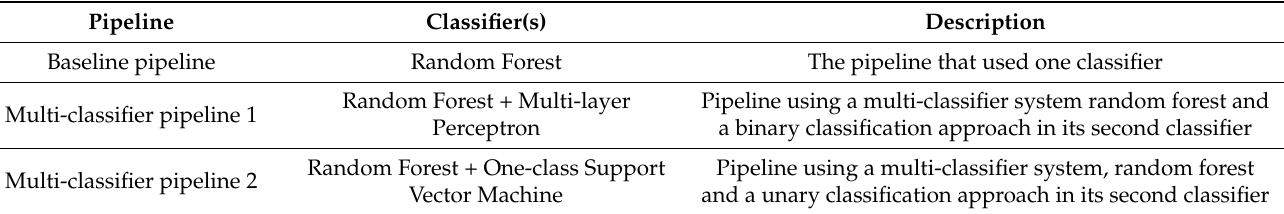
Table 2. The list of pipelines used in this